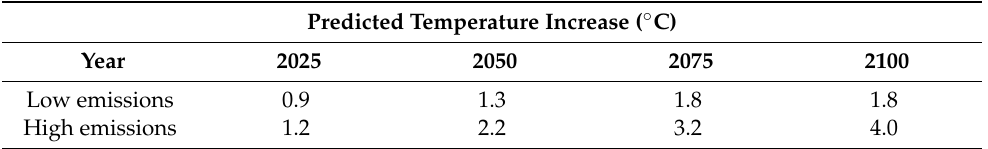
Table 1. Predicted temperature increases for 2025 to 2100 for a low-emission climate change scenario, and a high-emission climate change scenario, from the First IPCC first Assessment Report for the West, Middle, and East Delta regions of Egypt [46].